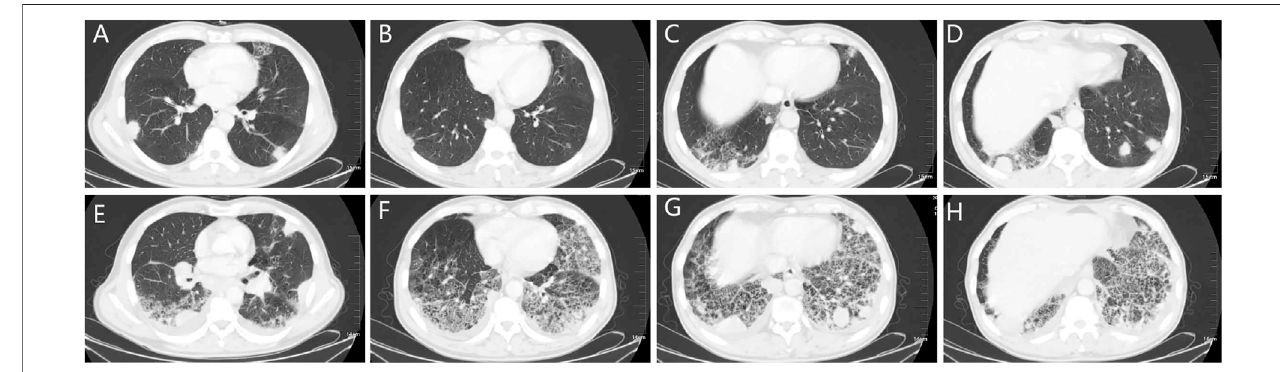
FIGURE1| ThechestCTofpatientone. (A – D) :chestCTshowingthenodesinthelungsandthelocalgridchangeintherightlowerlobe. (E – H) :chestCTshowing the pneumonitis 74 days after afatinib therapy, the pneumonitis manifested subpleural reticular shadow, ground glass and consolidation, and beehives, distributed in both lower lobe of both lungs. CT: computed